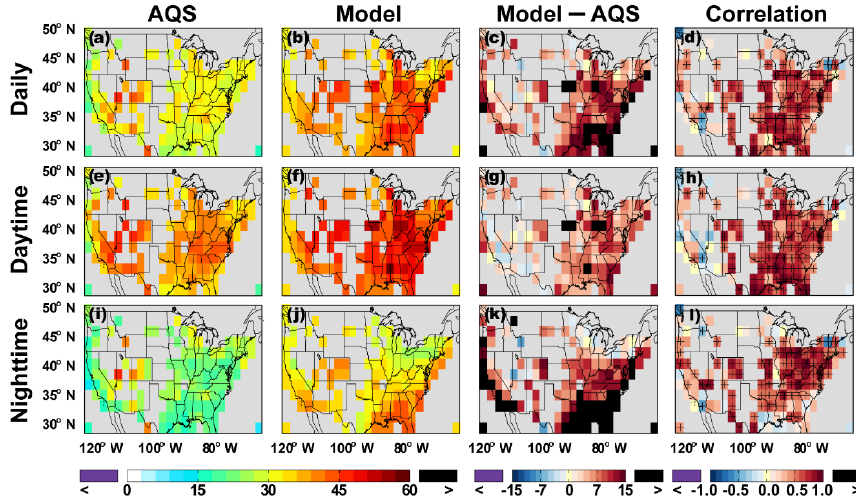
Figure 10. Observed and modeled 2004–2012 average daily, daytime, and nighttime mean ozone (ppb) over the US, as well as model biases (ppb) against and interannual correlation to the observations. Grid cells with statistically significant correlation coefficients are highlighted by + . The grid cells in grey have no AQS data.